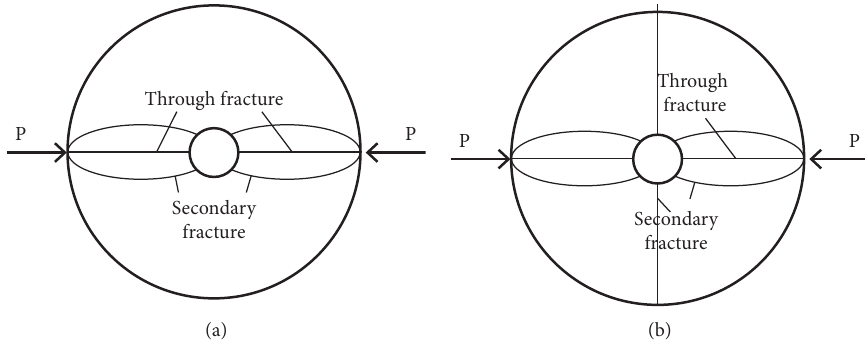
Figure 9: Simplified failure modes of precentral hole disc specimens under (a) type A and (b) type